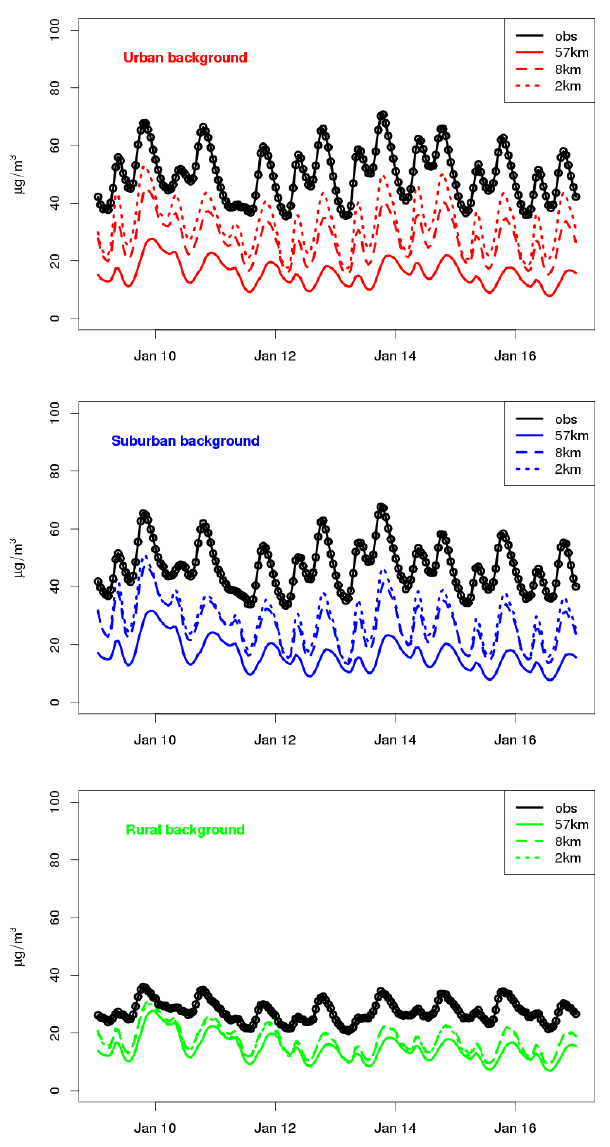
Fig. 3. Average time series of hourly NO 2 (µgm − 3 ) observed at, from the top to the bottom, urban, suburban and rural background monitoring stations in the Paris area (black) and interpolated in the CHIMERE model simulations at the 57km (solid), 8km (dashed), and 2km (dotted) resolution.